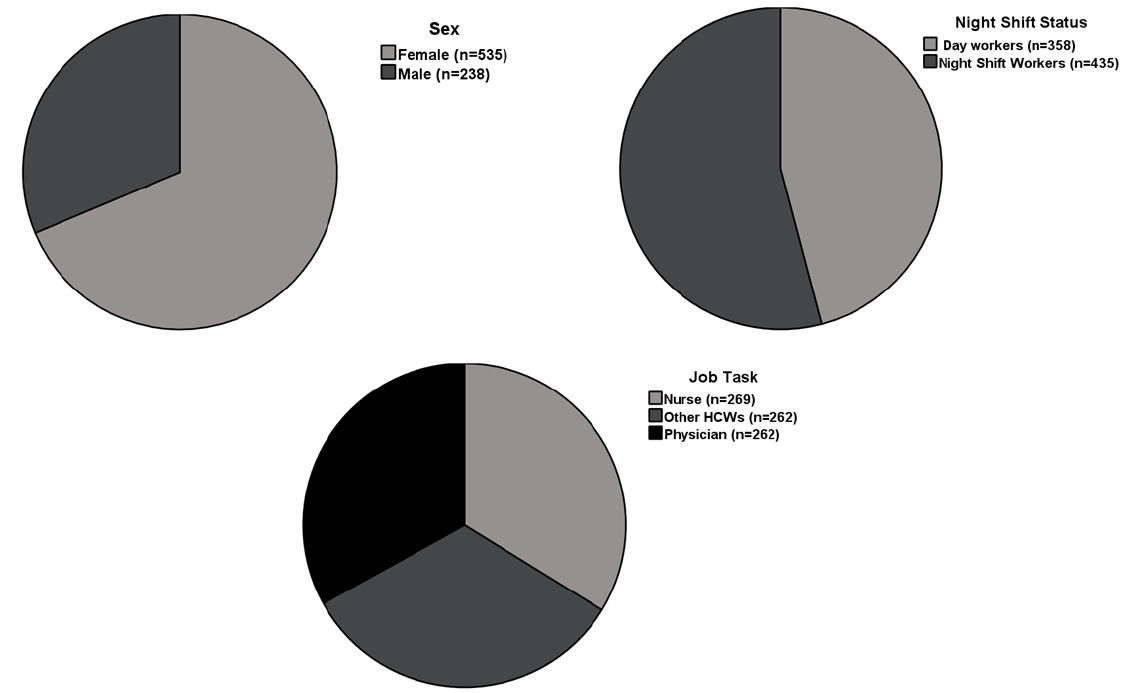
Figure 1. Study pie charts summarizing main characteristics of study participants.